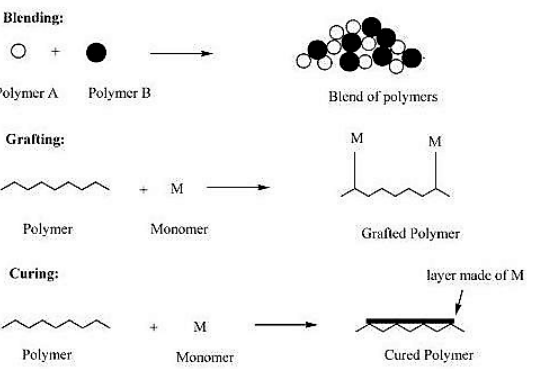
Figure 24. Schematic representation of polymer modification methods [281]. Reproduced with permission from Bhattacharya, A.; Misra, B.N, Progress in Polymer Science; published by Elsevier, 2004.